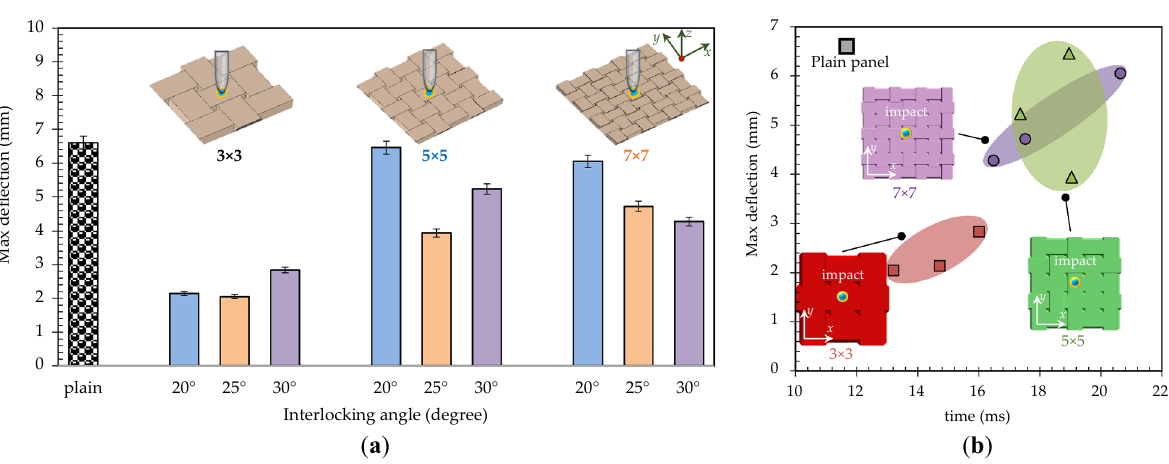
Figure 5. Impact testing of ceramic panels: the 3D DIC displacement field in z direction for the interlocked ceramics with the interlocking angles ( θ = 20°, 25°, and 30°) and the number of blocks (3 × 3, 5 × 5, and 7 × 7).